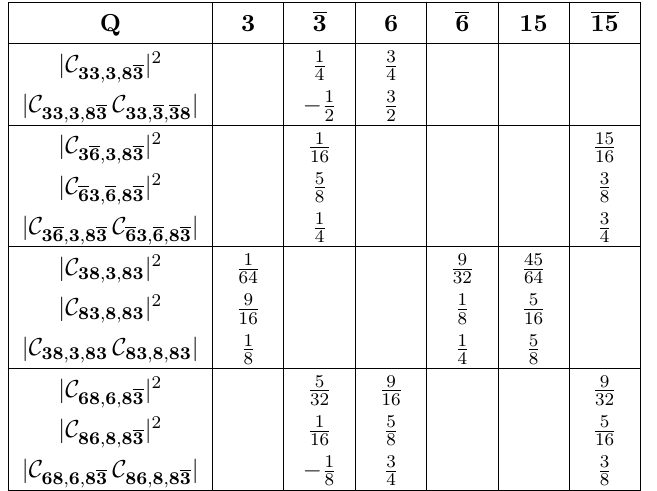
Figure 12 . The color (cid:13)ow in the t -channel diagrams that contribute to the mixed annihilation cross-sections. The arrows denote the direction in which the color charges of the respective particles (cid:13)ow.